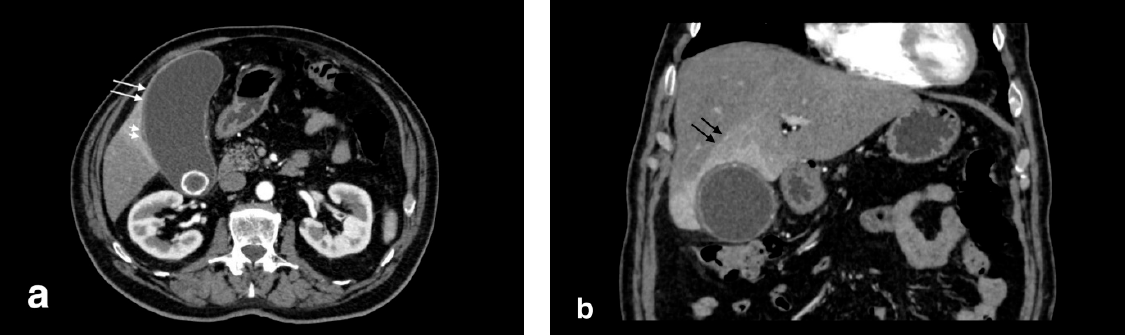
Figure 1. Acute uncomplicated calculous cholecystitis: ( a ) overdistended gallbladder with diffuse wall thickening and hyperemia (white arrows) and pericholecystic fluid (arrowheads), ( b ) pericholecystic parenchymal enhancement (black arrows).